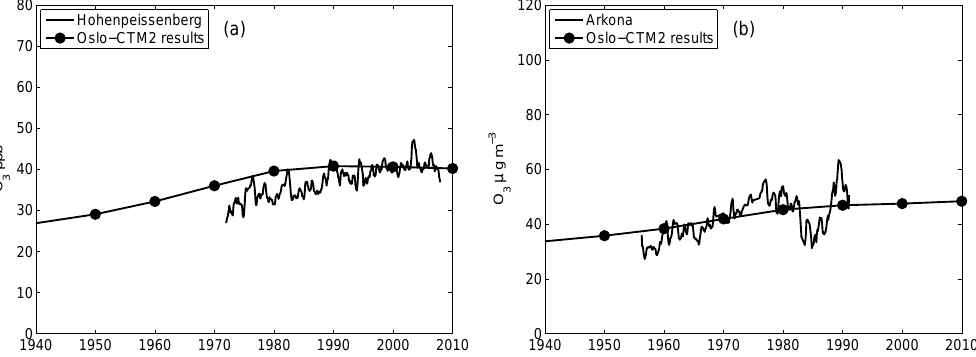
Fig. 7. Time series of surface O 3 at Hohenpeissenberg (a) and Arkona (b) . Annual mean model values (black dots) and 12-month smoothed Figure 7: Time series of surface O 3 at Hohenpeissenberg (a) and Arkona (b). average for the observations (solid Annual mean model values (black dots) and 12-month smoothed average for the observations (solid line).